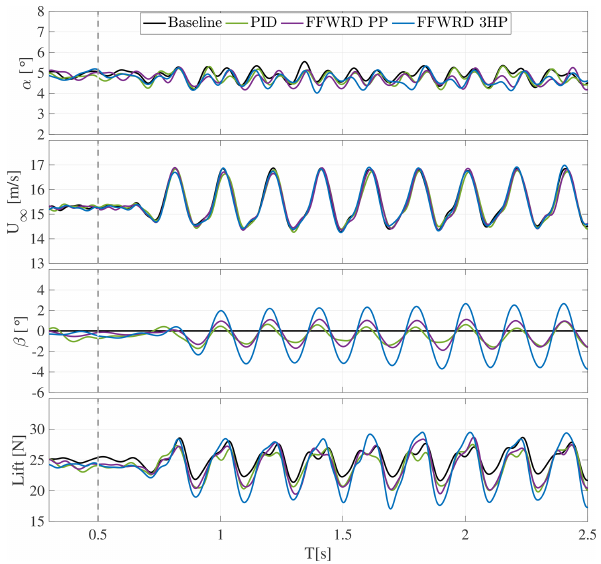
Figure D5. Time series of angle of attack and velocity variation, flap motion, and resulting lift amplitude at a reduced frequency of k = 0 . 319.